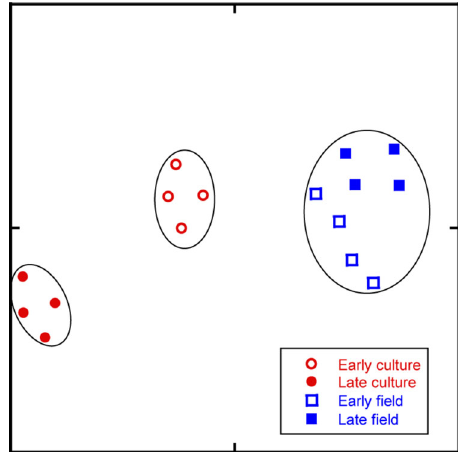
Fig. 2 Dimensionality reduction and cluster identi fi cation of expression data from all genes using t-SNE and DBSCAN. Two-dimensional t-SNE plot of normalized and log-transformed expression pro fi les from mapped read data generated by Bowtie2 for the samples from the four groups (diapause program: EF, LF; reproductive program: EC, LC). The perplexity parameter was set to 5, and 50,000 iterations of the t-SNE algorithm were run. The DBSCAN algorithm was followed by the calculation of the Dunn index to determine the optimal grouping of points into clusters (enclosed in black ovals). Samples are coded by fi ll (open: early [E]; fi lled: late [L]) and by symbol and color (blue squares: fi eld [F]; red circles: culture [C]).